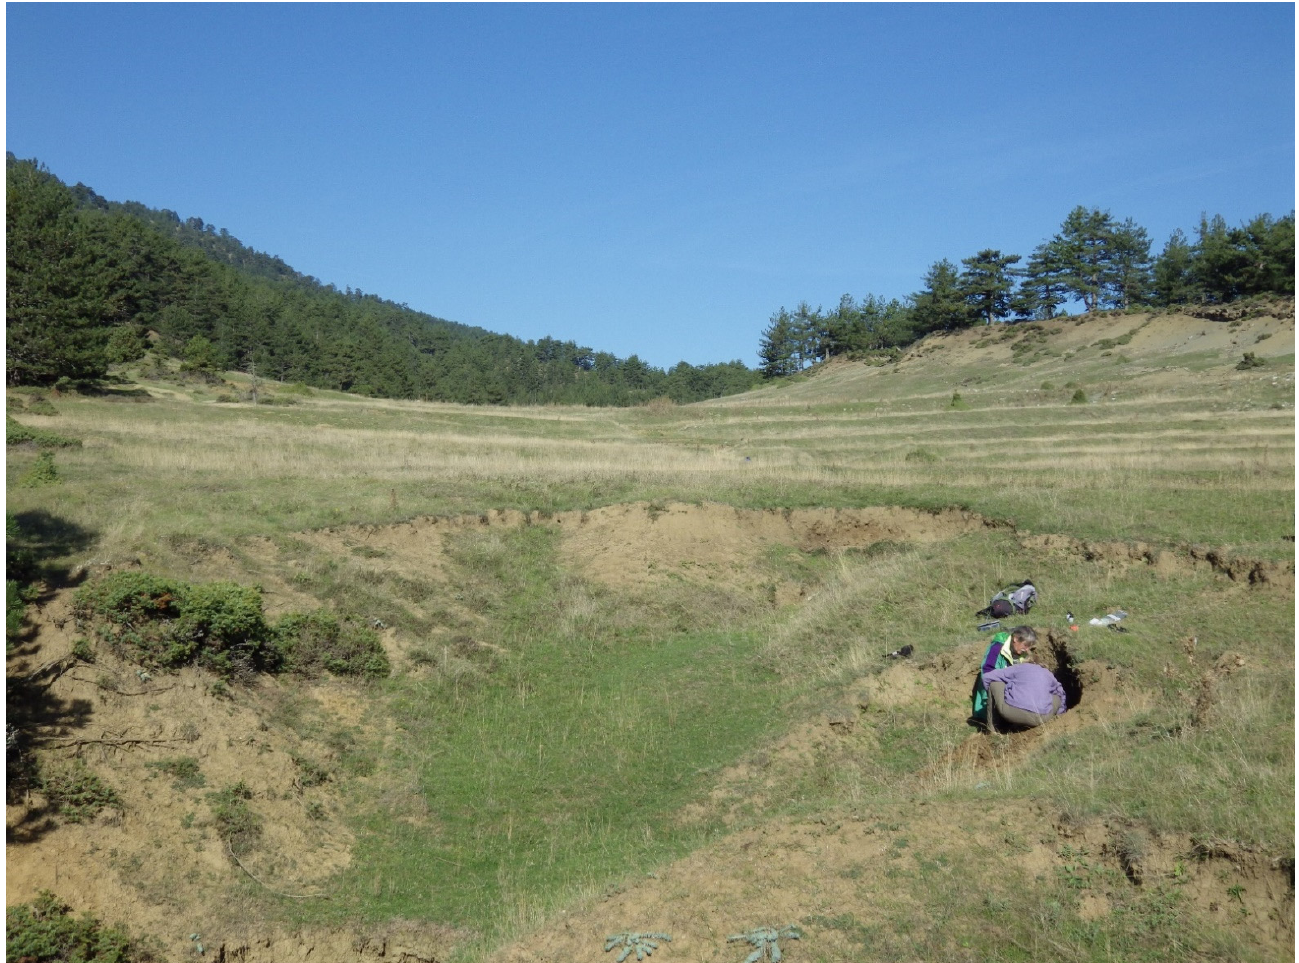
Figure 11. Agios Athanasios: Sampling charcoal from a profile exposed by erosional processes within the Bronze Age site (AA) located on a terrace of the Venetikos River Valley, which yielded the result of 3070 ± 40 BP (GrA-61779: AA-1) (photograph by P. Biagi, 2014).